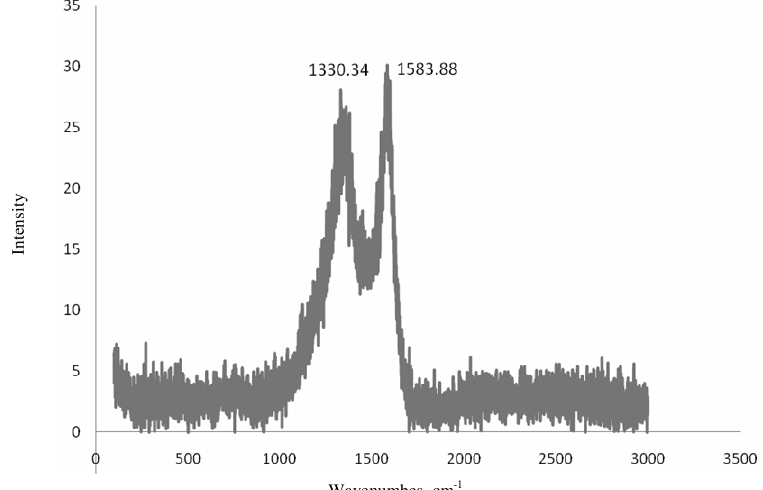
Figure 3. Raman spectra of sooth obtained from the combustion of